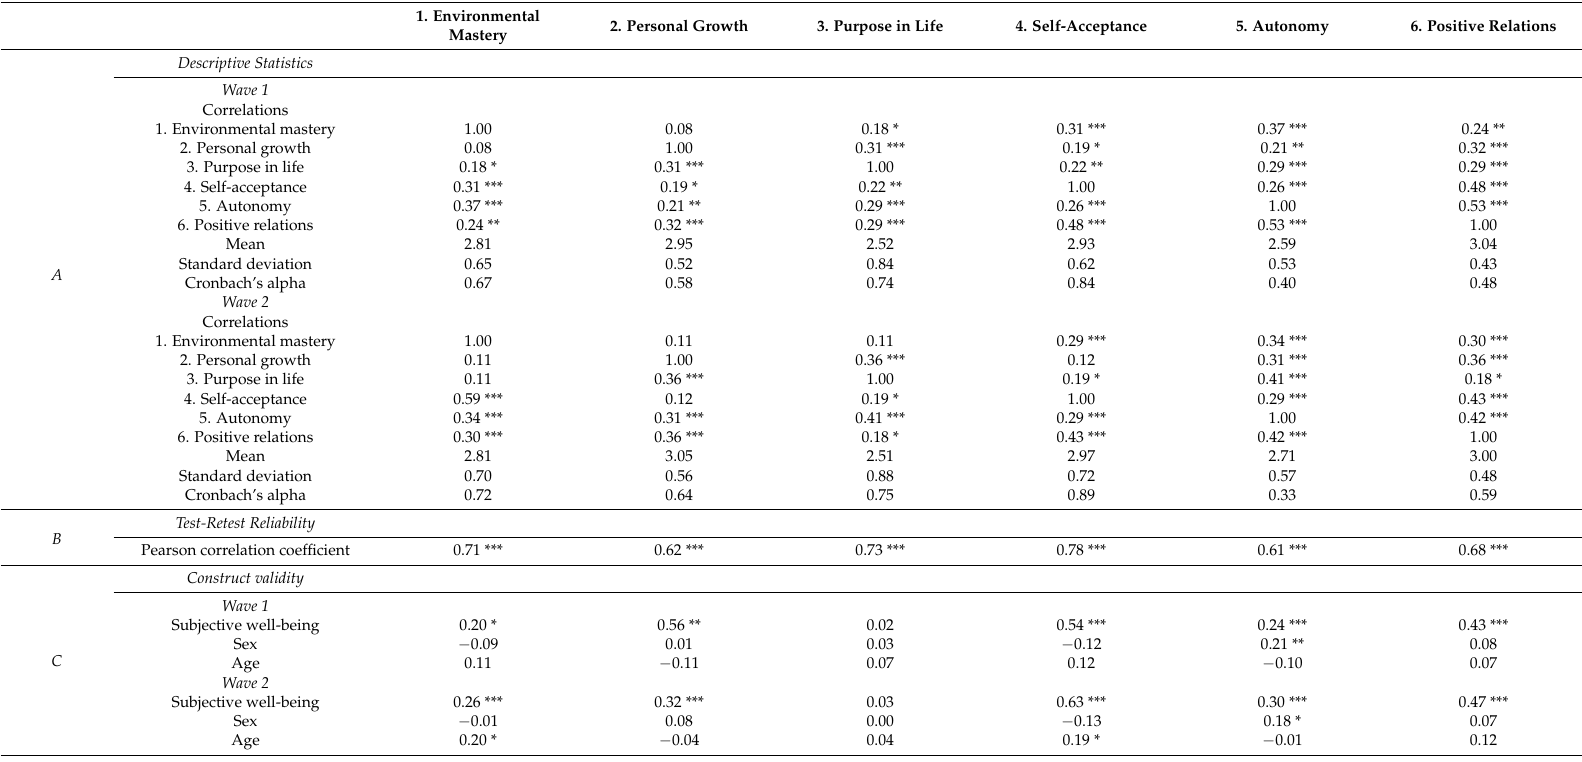
Table 2. Descriptive statistics, test-retest reliability, and construct validity for each dimension of psychological well-being scale for children (Pilot study, 24-item version, N =